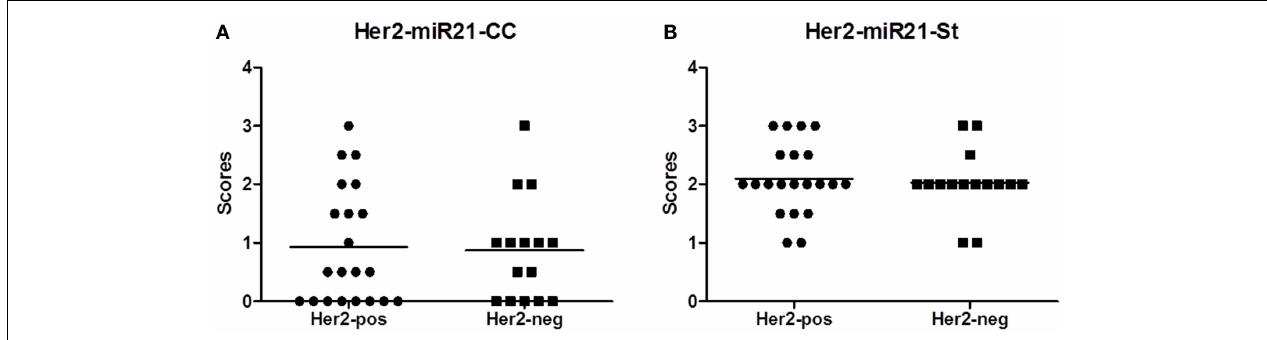
FIGURE 2 | MicroRNA (miR)-21 scores in the HER2 reference group. The miR-21 scoring was performed as described in Material and Methods section, here presented as average scores of two observers: miR-21 CC (A) and miR-21 St (B) .